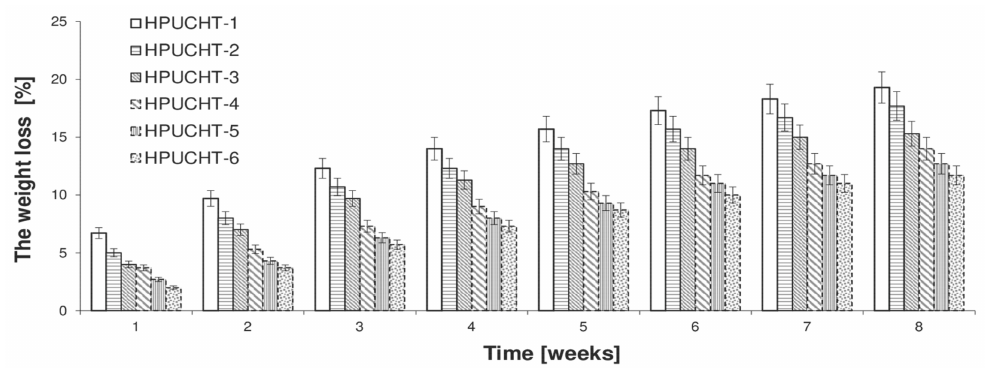
Figure 2. The weight loss (WL) of the obtained